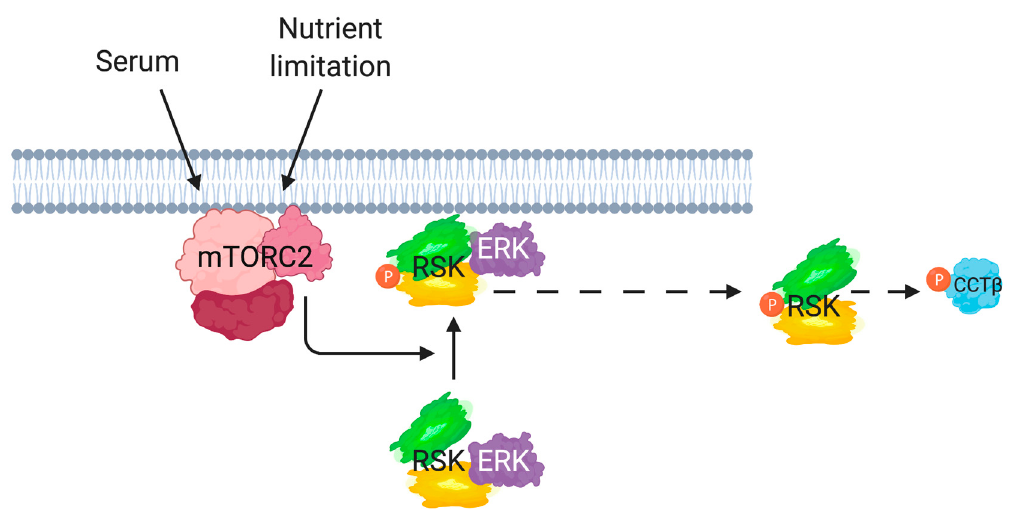
Figure 8. Model of mTORC2 regulation of RSK. In response to serum/growth factor stimulation or upon nutrient withdrawal, RSK phosphorylation (shown in orange) at the hydrophobic motif site (Ser380), located at the linker region between the NTKD (green) and CTKD (yellow), requires an intact mTORC2 but not mTOR catalytic activity. SIN1 associates with and colocalizes with RSK at the plasma membrane. mTORC2 could serve as a scaffold to potentiate the CTKD-mediated RSK HM phosphorylation. The CTKD is activated by ERK. mTORC2 is also required for the phosphorylation of the RSK substrate CCT β .